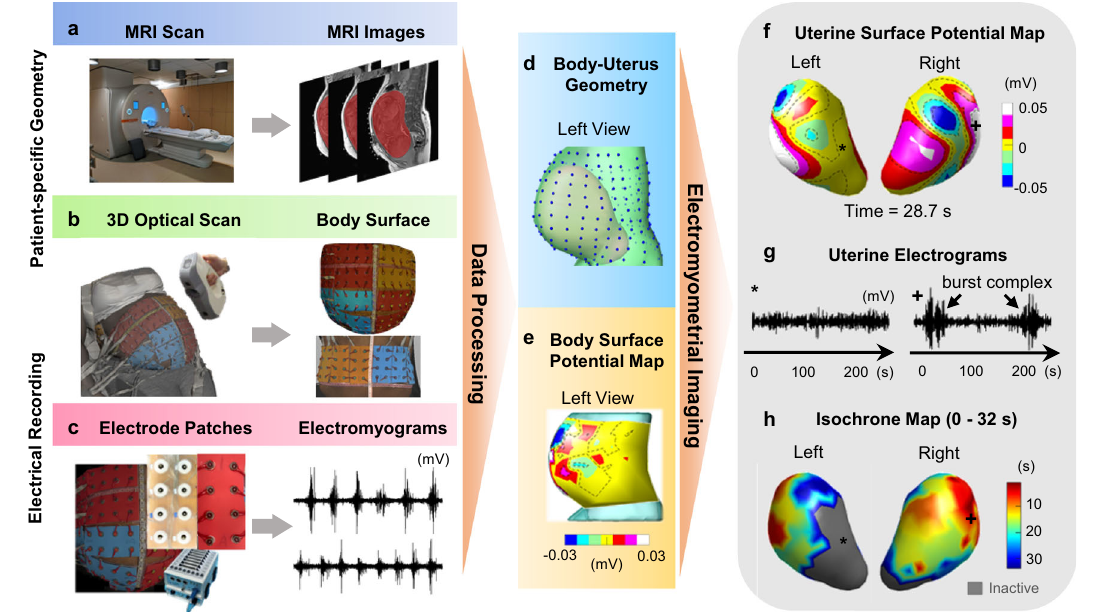
Fig. 1 | The pipeline of the human EMMI system. a An MRI scan is performed while the subject is wearing up to 24 MRI patches containing up to 192 markers. b Anoptical3Dscan of the bodysurface isperformed while the subjectiswearing electrode patches in the corresponding positions as the MRI patches. c Body surface electromyograms are simultaneously recorded from up to 192 pin-type unipolar electrodes assembled as patches. EMMI generates d , a body-uterus geo- metryfrom MRimages with electrodelocationsonthe bodysurface and, e abody surface potential map by rendering the electromyograms at each electrode at an